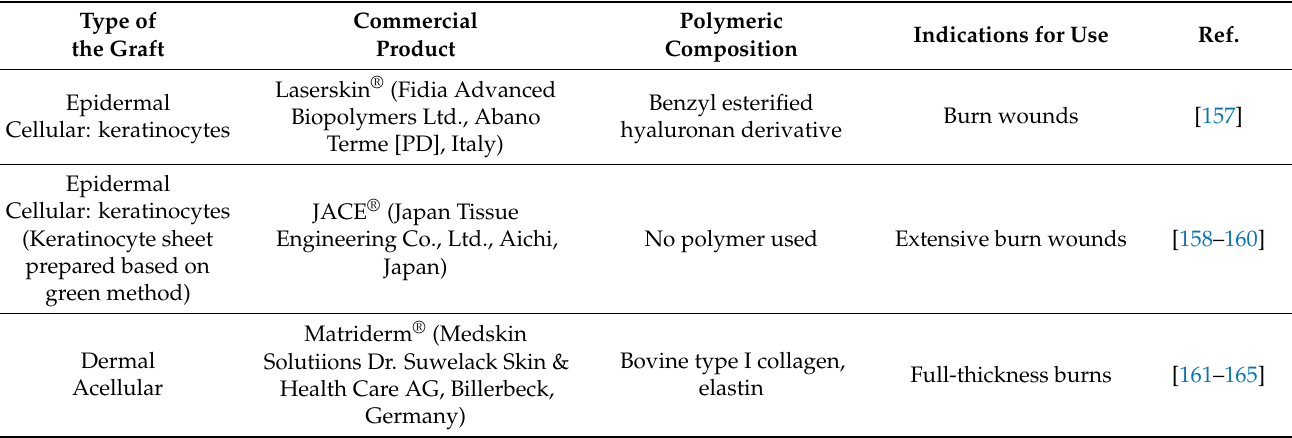
Table 1. Commercially available skin substitutes for the treatment of burn